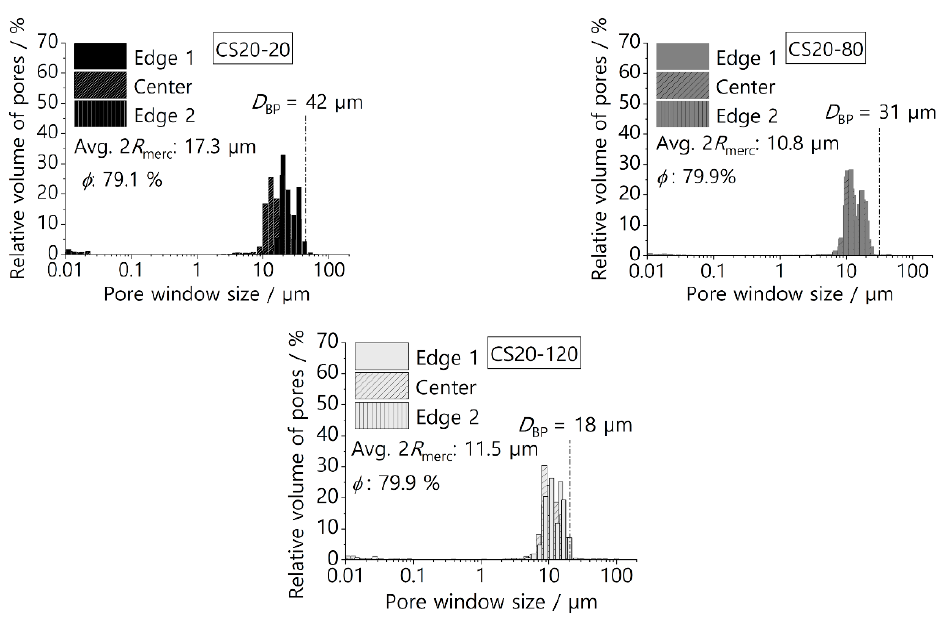
Figure 7. Hg intrusion porosimetry diagram for samples with 30 wt% of solid loading for different temperatures of freezing. Dashed lines indicate the biggest pore window size calculated based on the bubble point pressure 𝐷 (cid:2886)(cid:2900) . Overall, the average pore window size varies between 8.2 µm and 17.3 µm depend- ing on the freezing temperature and solid loading, and the pore sizes can be found in the range between 6 µm and 43 µm. Within the same sample, an extensive overlap of pore size distribution from the edges and the center of the screen can be seen, which confirms (quantitatively) the homogeneity of the screens. The quantitative results shown in Figures 6 and 7 confirm the qualitative observations in Figure 5 regarding the decrease in pore window size with the decrease in freezing temperature. The average open porosity varies